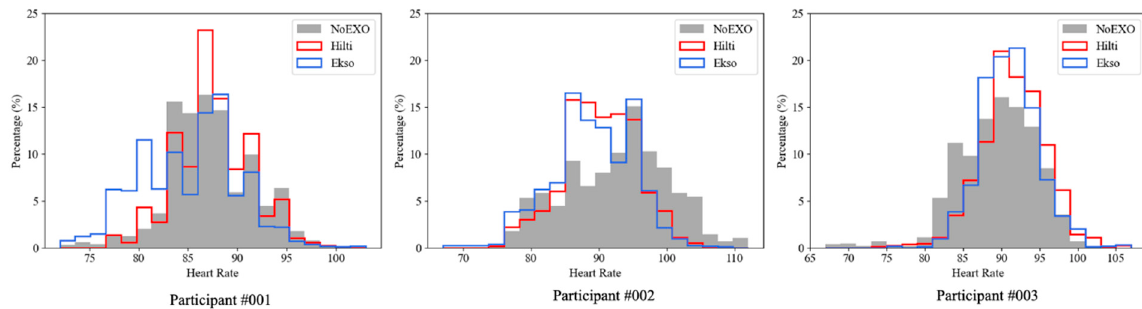
Figure 14. Distribution of the heart rates for individual participants during Task 1.